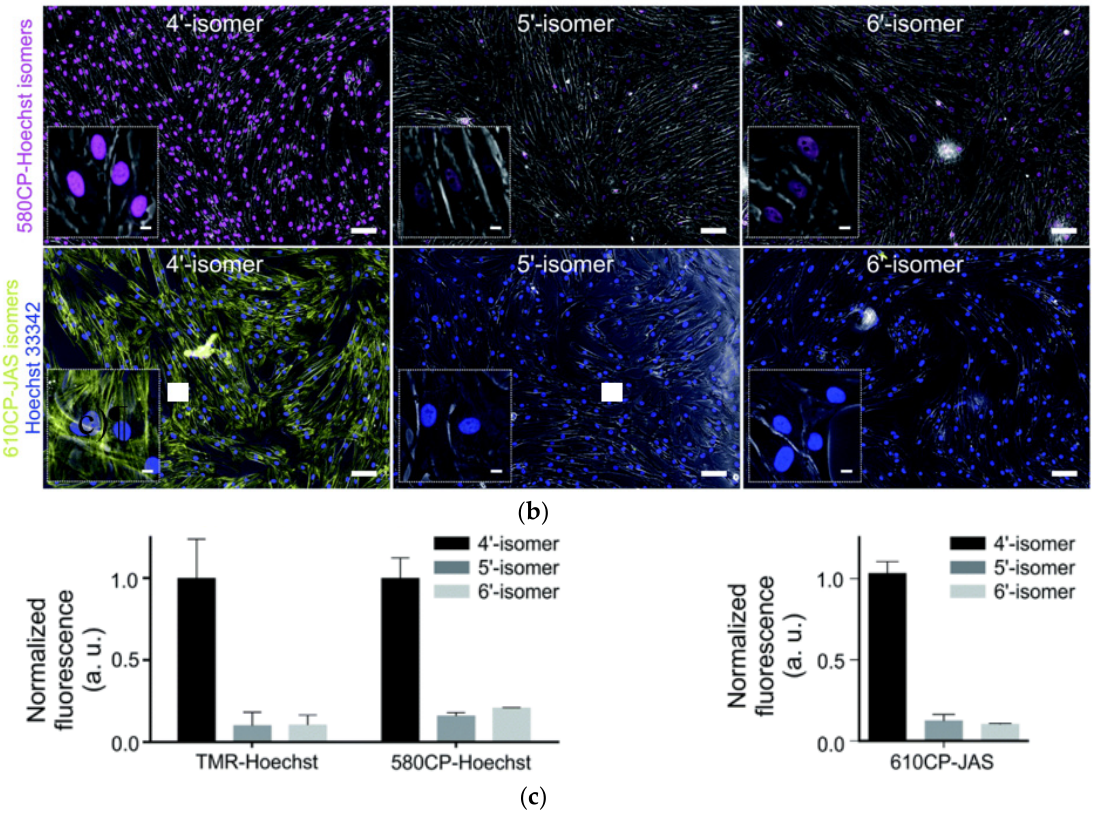
Figure 23. Neighboring group effect related enhancement in biocompatibility: ( a ) 4-TMR-COOH , 4-580CP-COOH , 4-610CP-COOH and 4-SiR-COOH dyes and conjugates. Their photo-physical properties are depicted in the color spectrum chart and the neighboring group effect is depicted; ( b ) Wide-field microscopy images of living primary fibroblasts, stained with 4/5/6-580CP-Hoechst (magenta) or 4/5/6-610CP-JAS (yellow); ( c ) Quantification of DNA probe fluorescence signal in the nuclei. Adapted with permission from [148]—Published by The Royal Society of Chemistry. Scale bars = 100 µm.